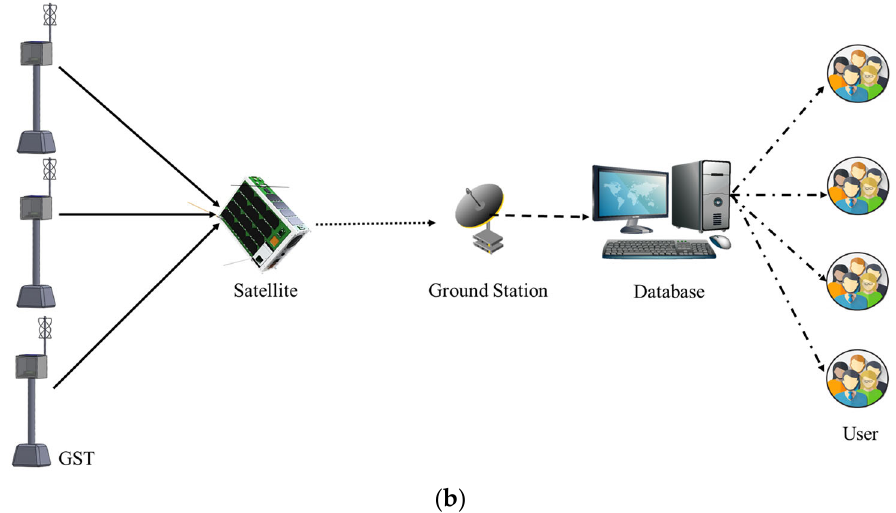
Figure 3. Implementation architecture of ( a ) SIoT for achieving full potential and ( b ) the proposed SIoT.